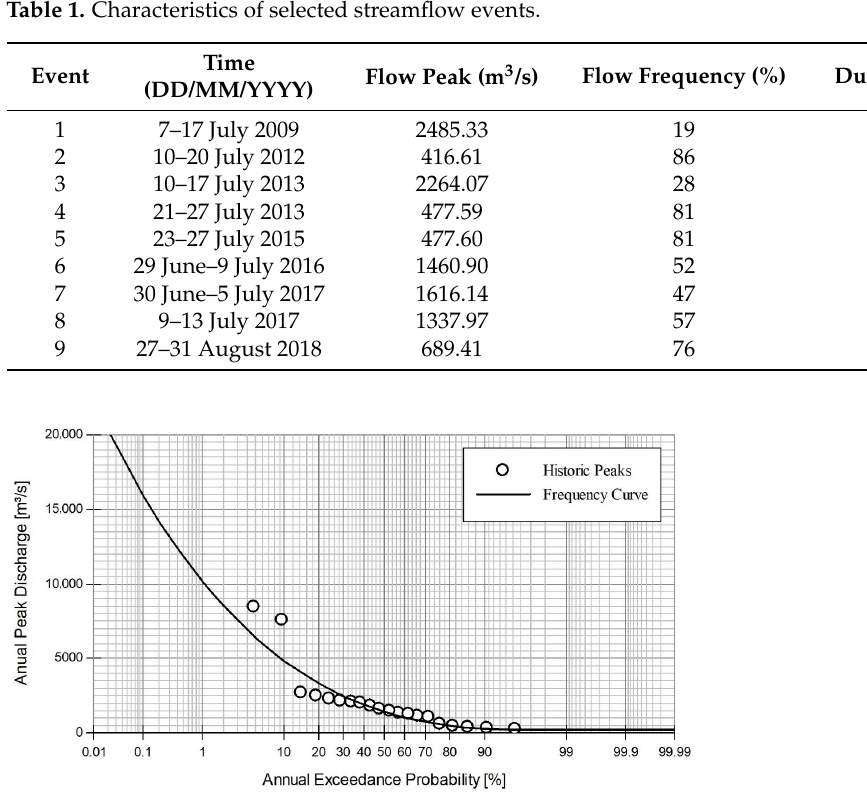
Figure 2. Flow frequency curve for the “Hongcheon” station; historic peaks refer to annual maximum peak flows from 2000 to 2019; the flood frequency curve is fitted using the Gamma distribu- tion.